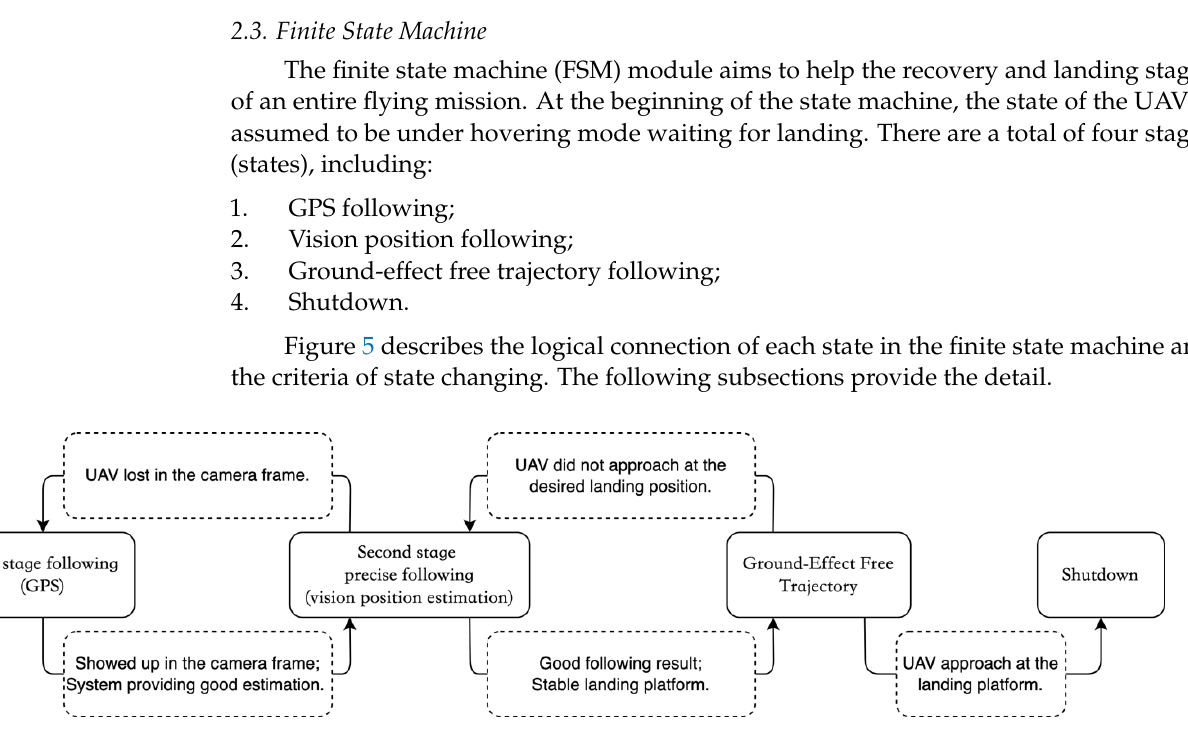
Figure 5. The framework of the finite state